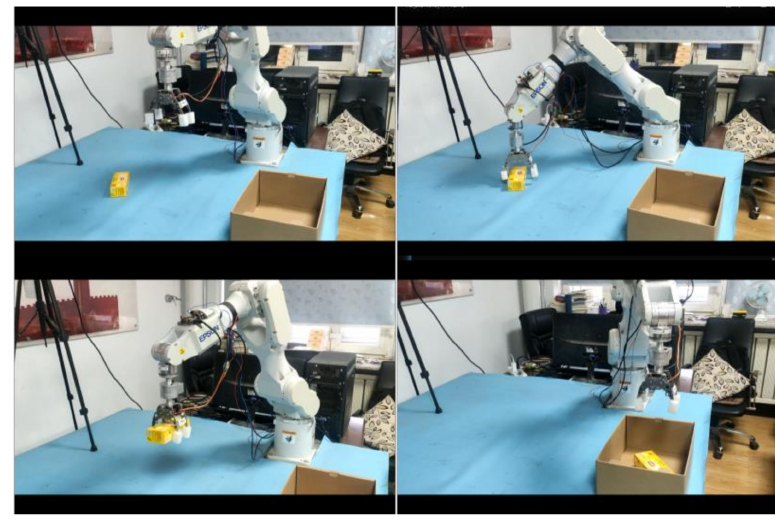
Figure 19. Single object grasping process.